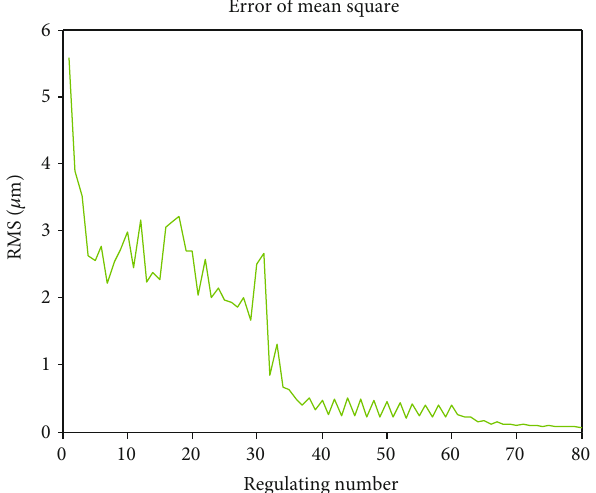
Figure 16: Root mean square (RMS) based on 25